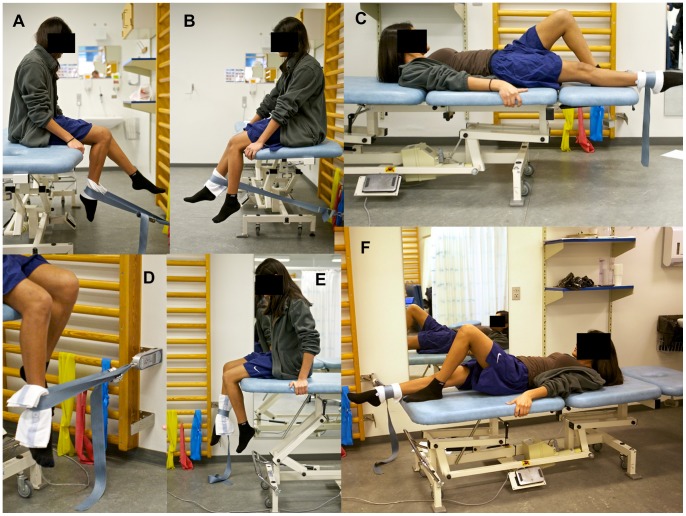
Isometric muscle strength test-positions.The figure shows the test-positions of the six movement directions during isometric knee and hip strength. A: knee flexion, B: knee extension, C: hip abduction, D: hip internal rotation, E: hip external rotation, F: hip adduction.